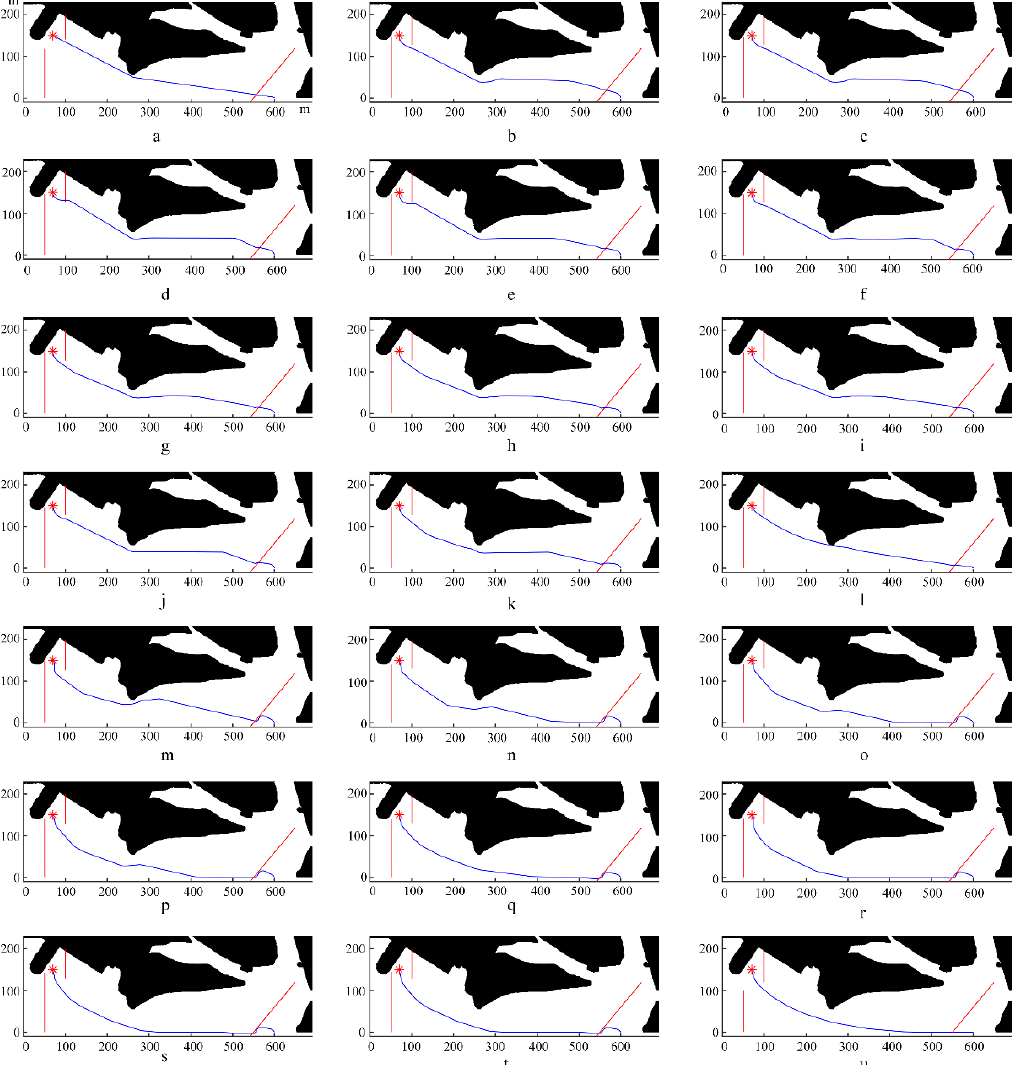
Figure 9. Final simulated paths under environmental factors with different intensities (( a – u ), the intensity coefficient gradually increases from 0 to 1 in 0.05 intervals). In each subfigure, “*” represents for the final destination, the red lines represent for the paths of dynamic obstacles, and the blue line represents for the simulated navigation path. Table 2. Results obtained from simulation experiments under environmental factors with different intensities.